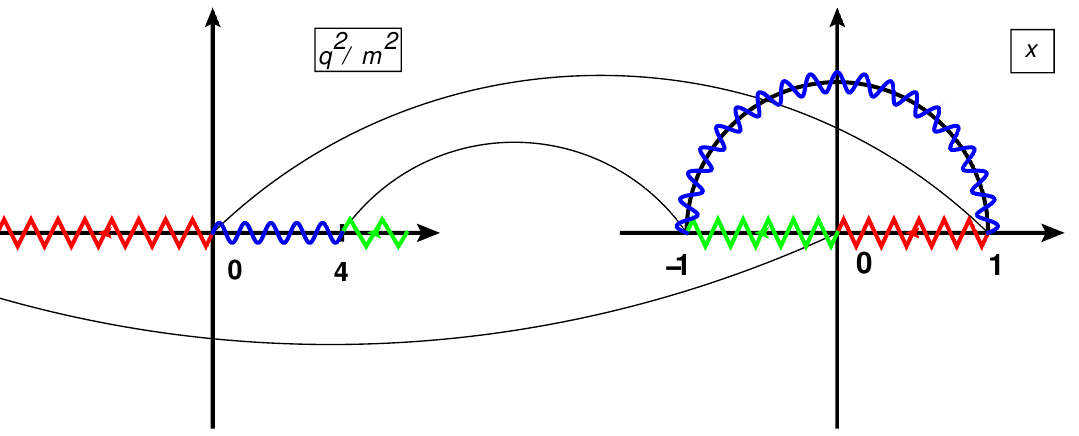
Figure 2 . Illustration of the variable transformation between q 2 /m 2 and x as given in eq. (2.1). The left graph represents the q 2 /m 2 plane and on the right the complex x plane is shown. The (coloured) wiggled and zigzag lines show the mapping of the various intervals, whereas the straight lines indicate the mapping for special values of q 2 /m 2 and x